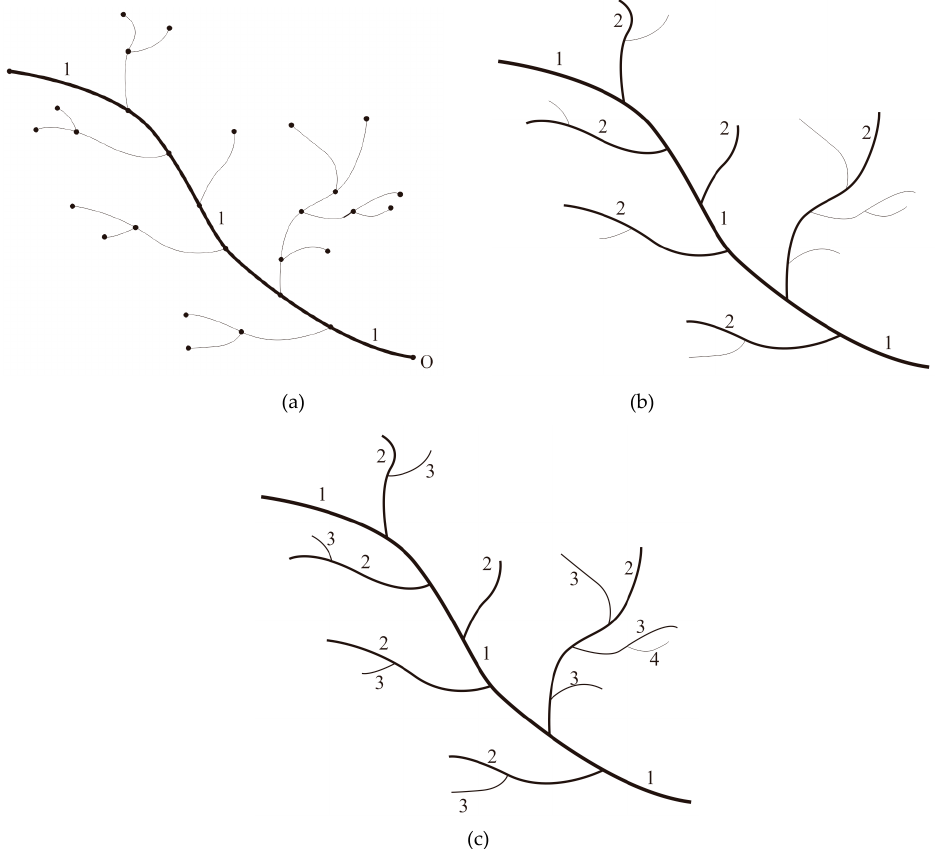
Figure 7. Procedures of the automated coding method for dendritic river features: ( a ) coding the main stem, ( b ) coding of tributaries and ( c ) final results of stream coding.